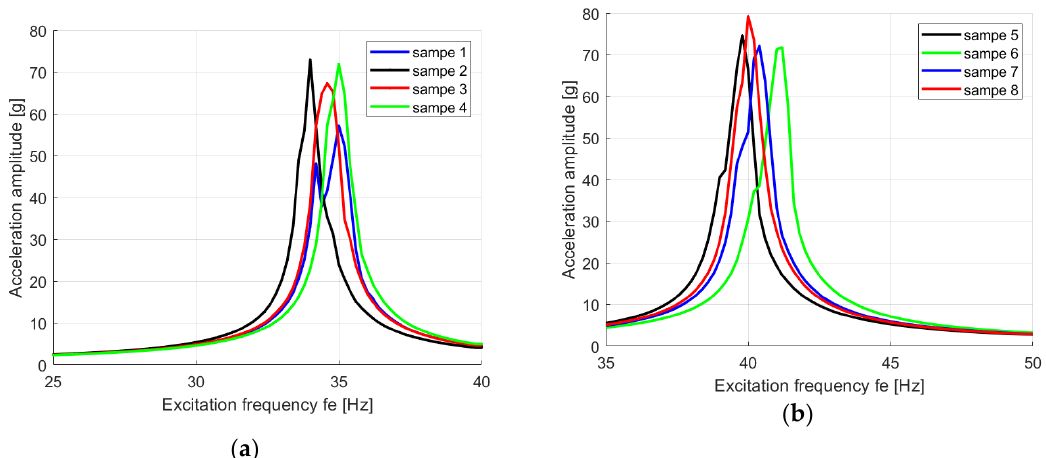
Figure 7. The response acceleration amplitude of the composite beams via excitation frequency at the first resonance zone of the samples cut along the x axis for the fabric configuration set 0/22.5/45/0/22.5/45 (a), and along the y axis for the fabric configuration set 90/67.5/45/90/67.5/45 (b).